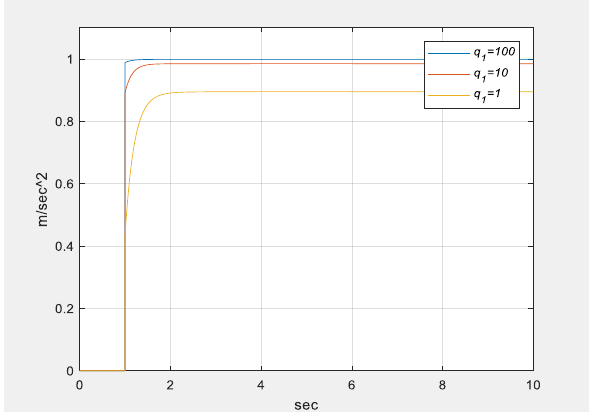
f generated by the simulator ( sx